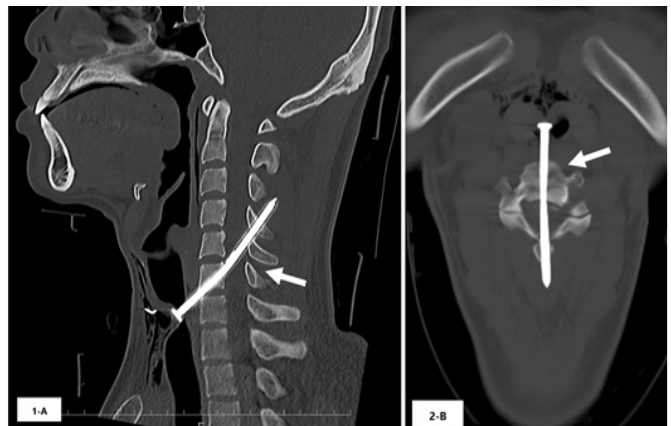
Image 1. Cervical computed tomography showing a 9-centimeter nail penetrating the trachea, anterior vertebral body, and spinal cord